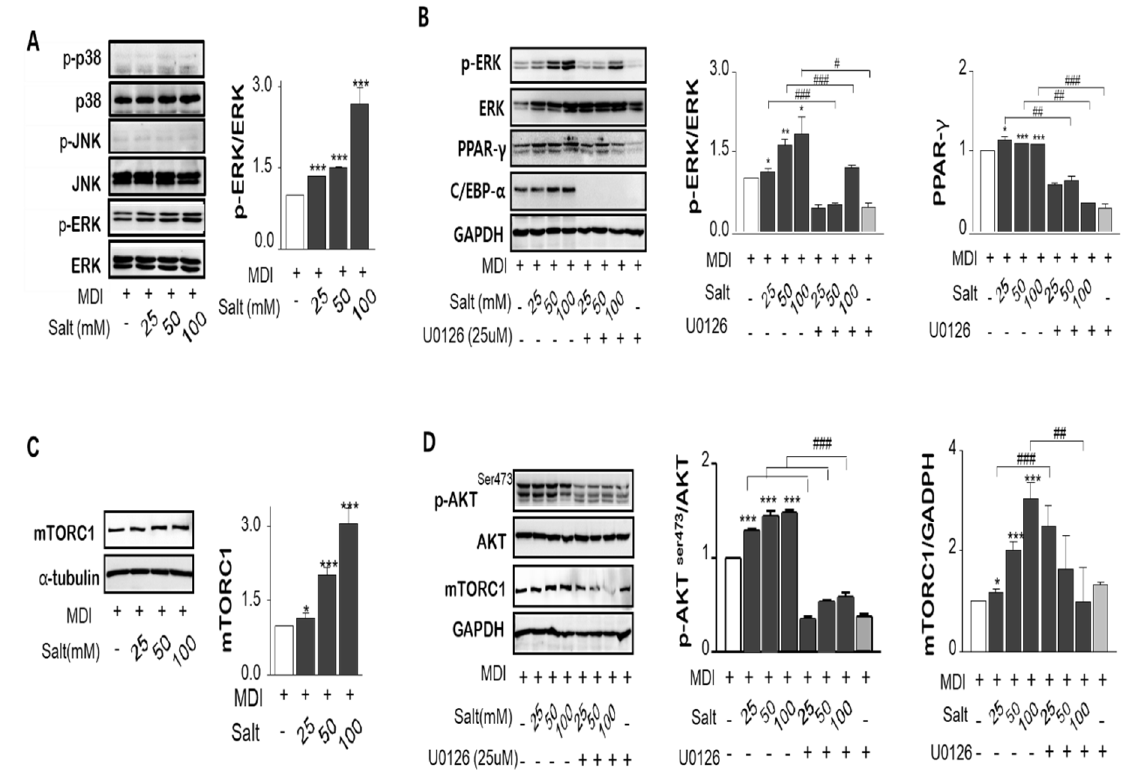
Figure 4. Salt regulates MAPK/ERKs and Akt-mTOR pathways. The ratio of phospho-ERK vs total ERK, phospho-p38 vs total p38 and phospho-JNK vs total JNK proteins were measured by immunoblotting. ( A ) U0126, inhibitor of MAPK and ERK, depressed the salt-induced up-regulation of p-ERK/ERK1/2, and PPAR ɣ . ( B ) Post-confluent 3T3-L1 preadipocytes were preincubated by MEK/ERK inhibitor for 24 h prior to induction of differentiation. The ratio of phospho-Akt Ser473 /Atk protein levels expression were increased by increasing salt treatment, but phosphorylation at Akt Ser308 was not involved. The inhibitor of MAPK/ERK, U0126, declined the salt-induced Akt activation and mTOR protein expression. ( C , D ). Data are expressed as mean ± SE of three independent experiments or more. * p < 0.05, ** p < 0.01, *** p < 0.001, significant difference vs control.